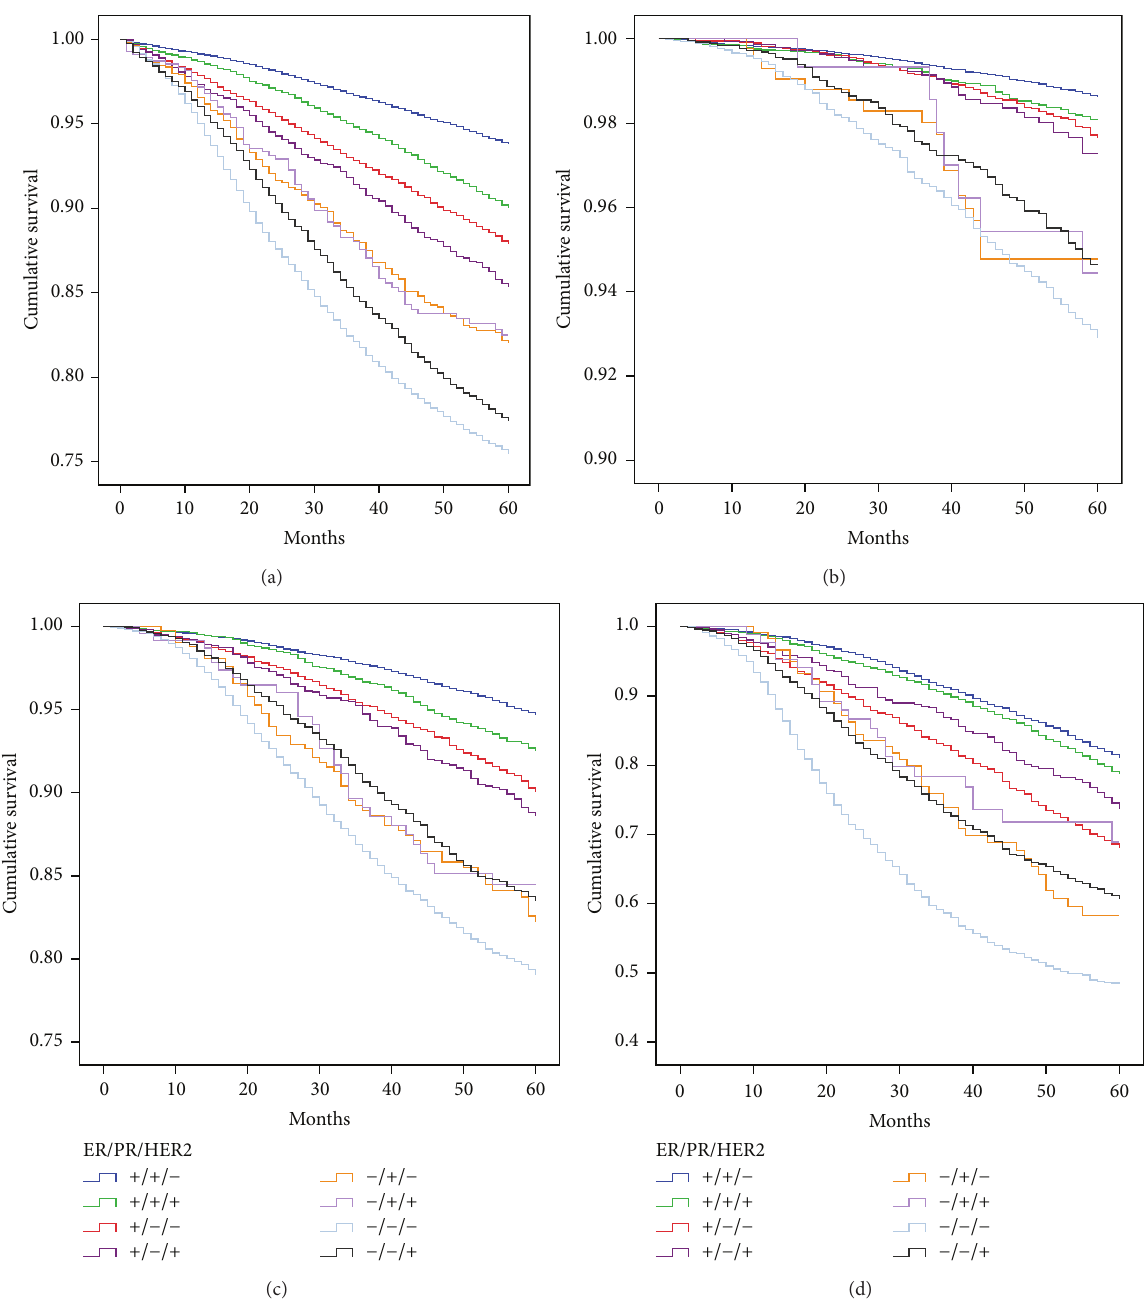
Figure 1: Kaplan Meier 5-year survival for the ER/PR/HER2 subtypes for all stages combined (a), stage 1 (b), stage 2 (c), and stage 3 (d).